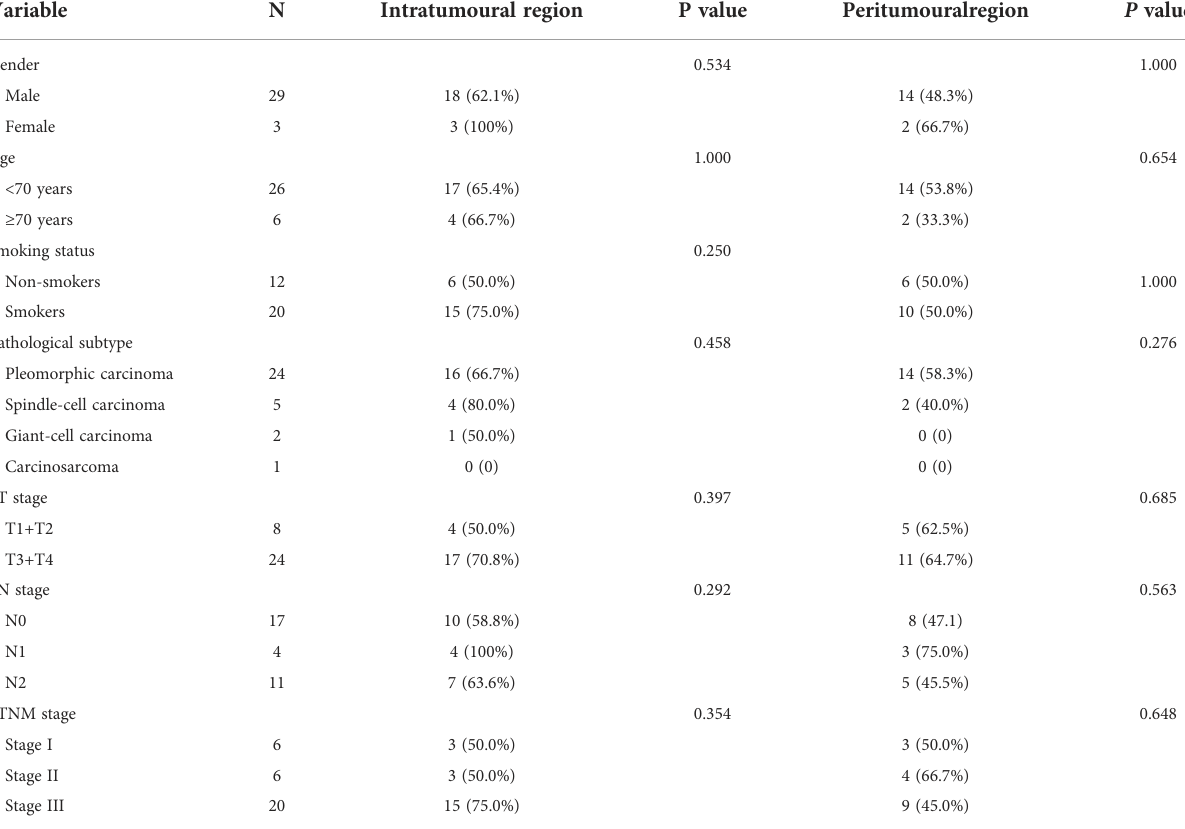
TABLE 2 Correlation between CD8+ T cell in fi ltration and clinicopathological features in PSC. Variable